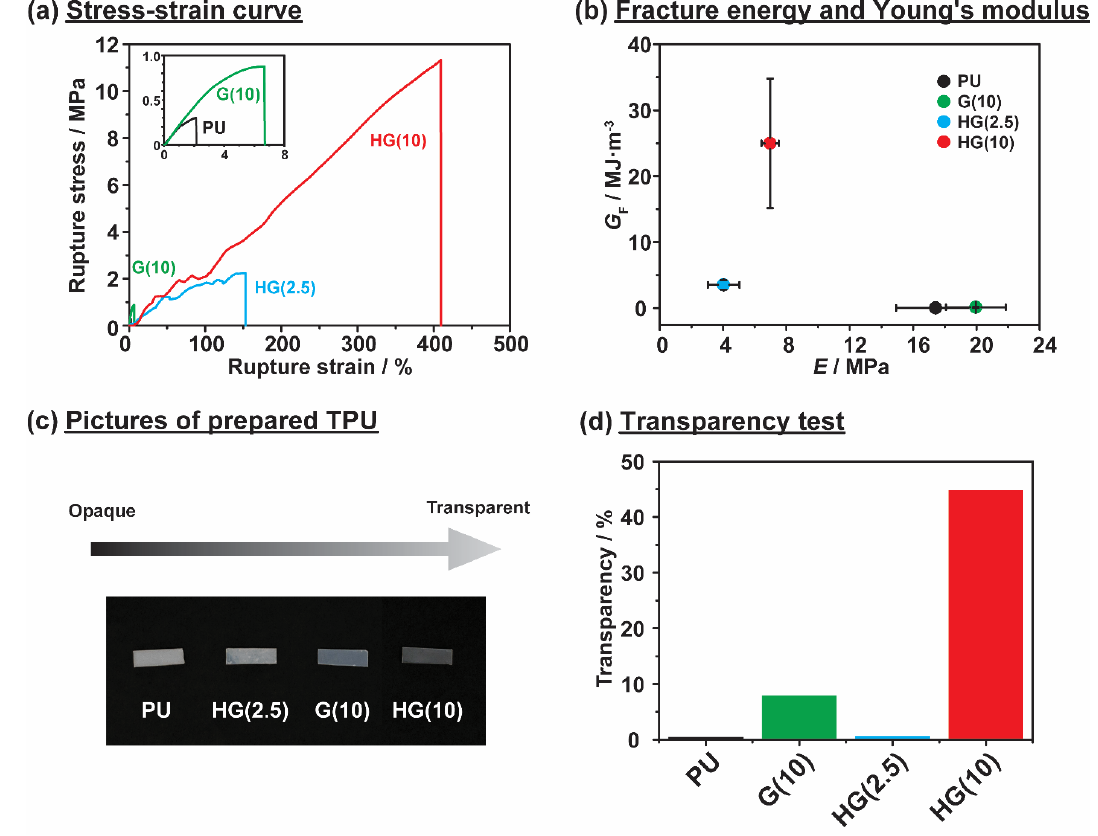
Figure 3. ( a ) Stress strain curve and ( b ) fracture energy ( G F ) with Young’s modulus ( E ) of all the